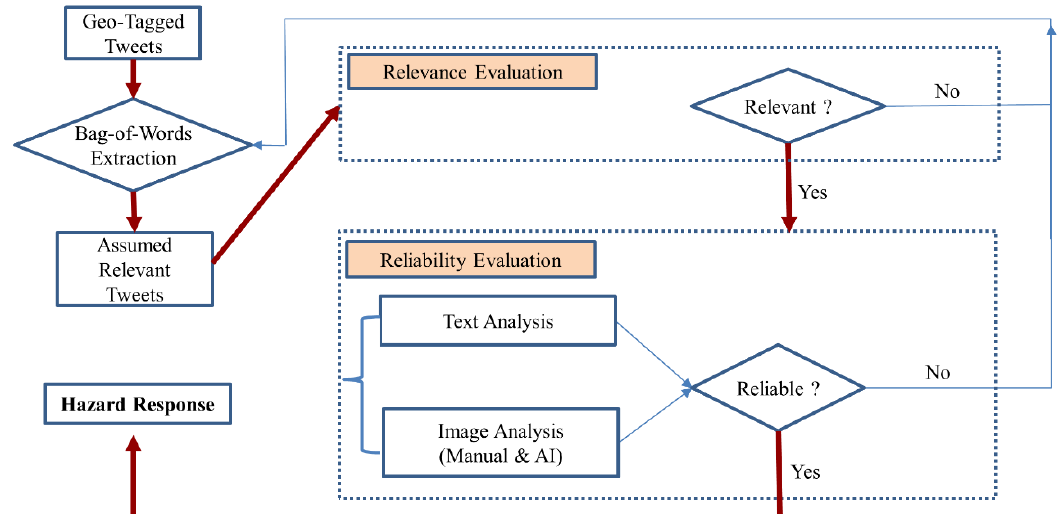
Figure 1. Reliability evaluation workflow.